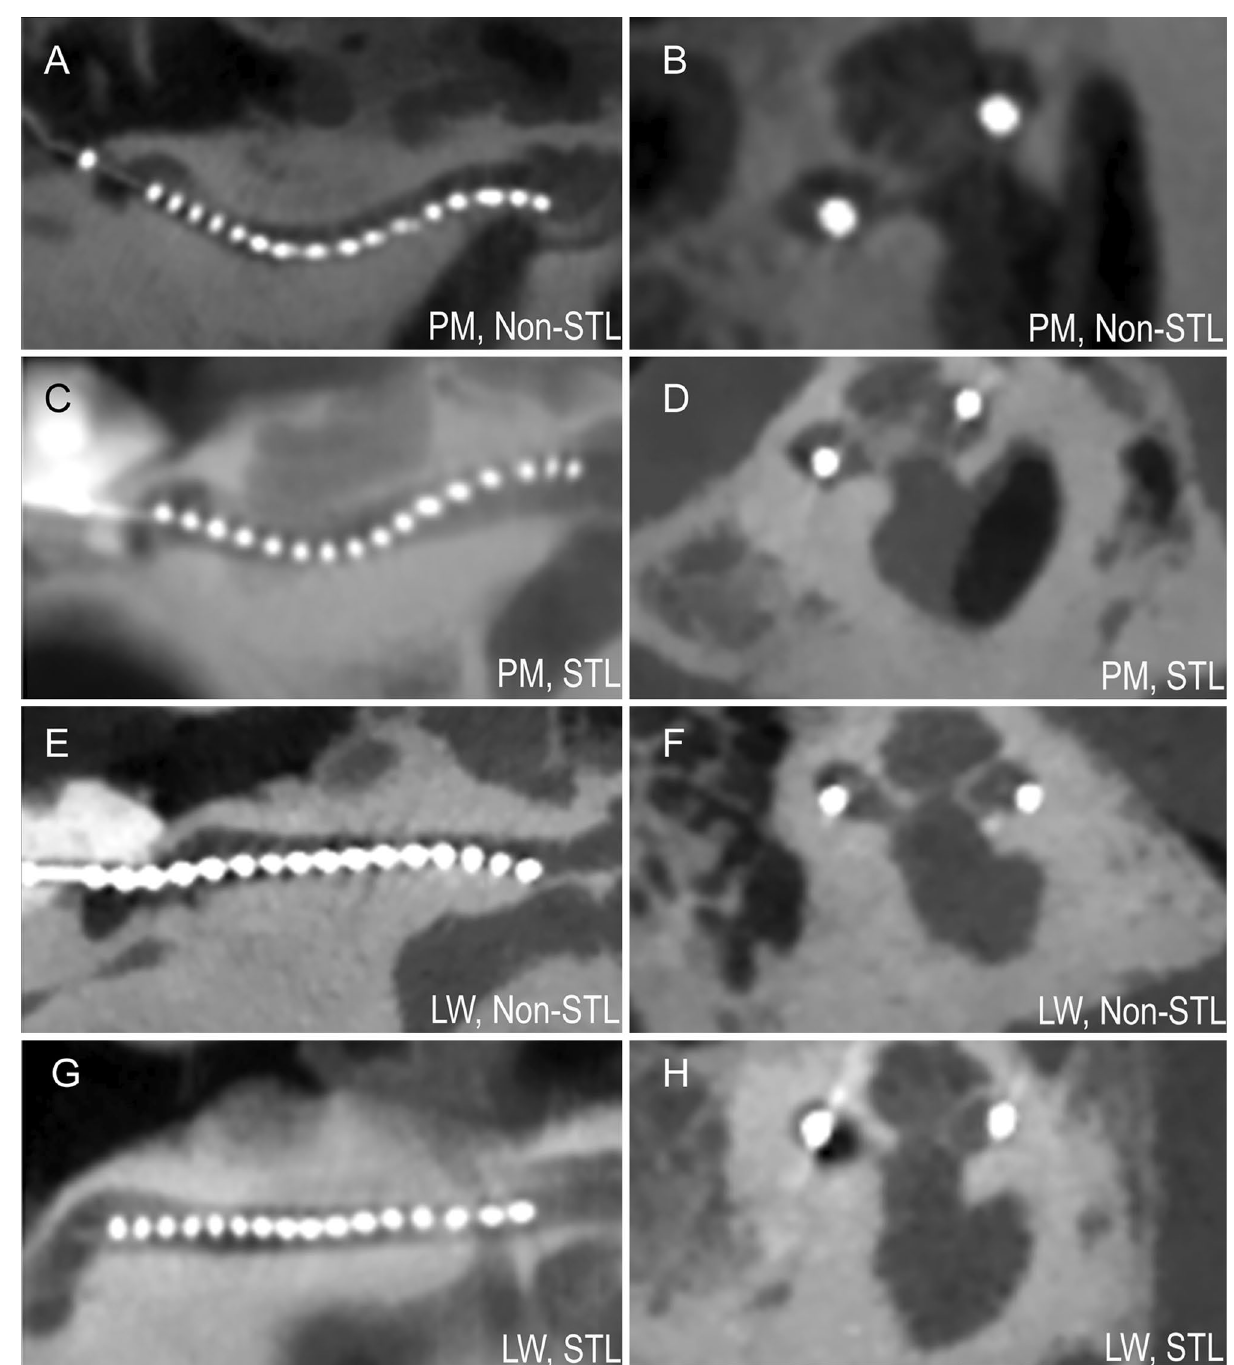
Figure 6. Assessment examples between uncoiled cochlear reconstructions (on the left) and conventional multiplanar reconstructions (on the right). In ( A ) the PM array is neatly following the scala tympani, which is located in lower half of the uncoiled cochlea. In ( C ), however, clear kinking of the PM array results in STL from scala tympani to scala vestibuli. This difference of PM non-STL vs. STL is also seen in conventional reconstructions in ( B,D ), with the array, the white dots, located in STL case of ( D ) more towards the upper half of the cochlea than in ( B ). In ( E ) the LW array follows the scala tympani without interruption, in contrast in ( G ), the LW array shows an subtle, but still clear kink towards scala vestibuli (i.e. STL). The different position of the LW array is difficult to observe in conventional reconstructions, see ( F ) vs. ( H